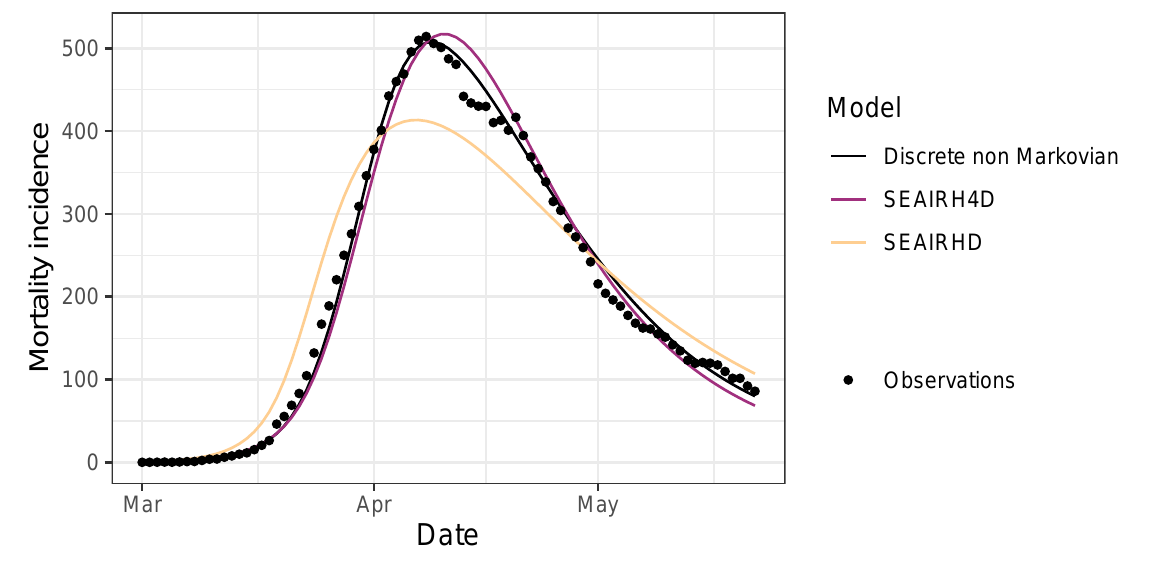
Figure S3 – Best fits to the observed mortality incidence for several models. We esti- mated the best fits to the observed data by minimising the Akaike Information Criterion (AIC). The SEAIRHD shows mediocre fit to the data (AIC: 1324) but taking into account a more realistic delay from infection to death, SEAIRH4D model, improves the estimations drastically (AIC: 730). The discrete time model with memory effects provides a better fit (AIC: